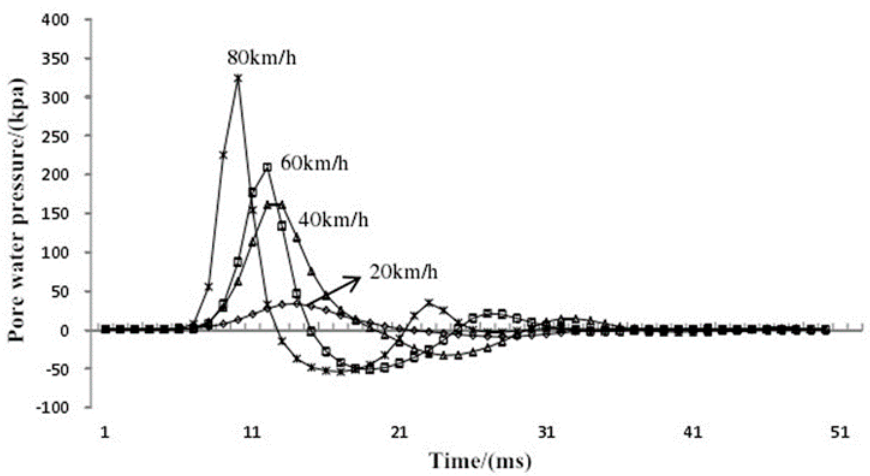
Figure 5. The variation of pore water pressure with time at different speeds.